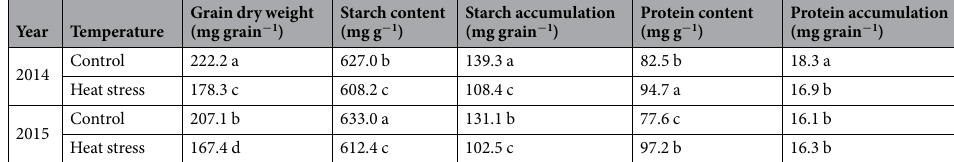
Table 1. The grain weight and contents of starch and protein at maturity under ambient and high-temperature conditions in two years. Values are means of three pots (three replicates). Values followed by different